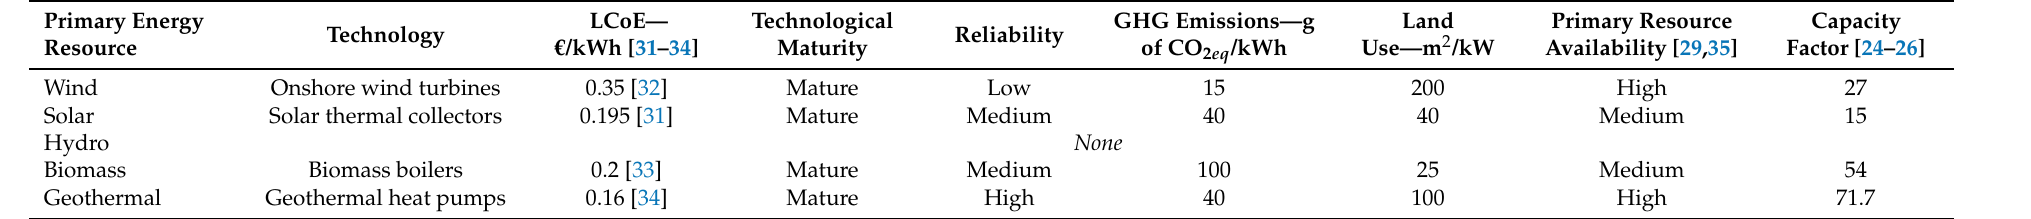
Table 2. Qualitative and quantitative measures of efficiency of several renewable primary resources